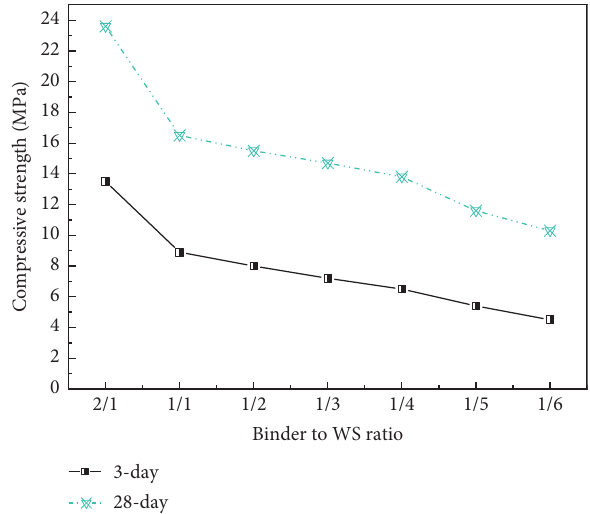
Figure 10: The compressive strength of the waste sediment-based grouting material with different binders to WS ratios.